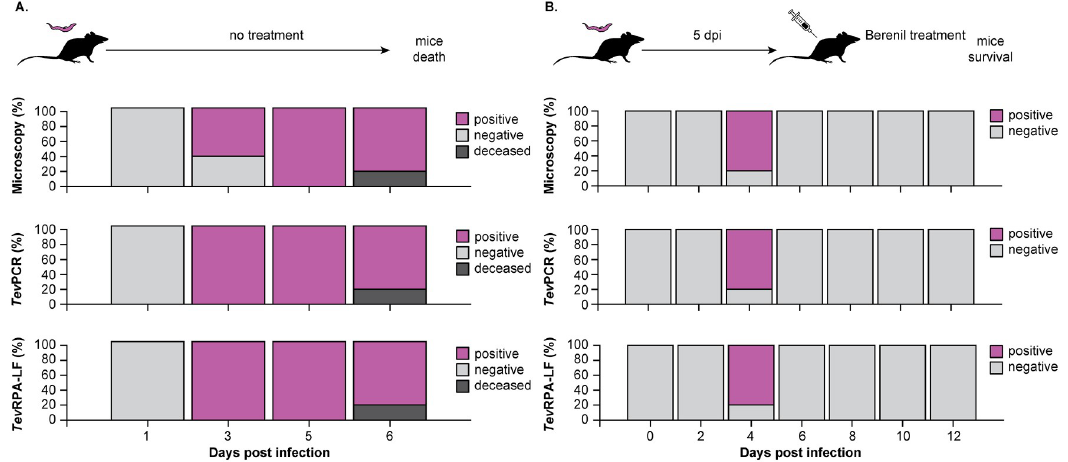
Fig 4. Evaluation of the Tev RPA-LF as a test-of-cure tool in T. evansi infections in mice. A: C57BL/6 mice were infected with T. evansi RoTat1.2 (n = 5) and the presence of parasites was monitored over the course of the infection by microscopy (top panel), the Tev PCR (middle panel, performed on parasite genomic DNA purified from the collected blood samples), and Tev RPA-LF (bottom panel, executed on crude parasite genomic DNA extracted from the collected blood). The results are displayed as the percentages of mice that scored positive or negative as determined by the above-mentioned techniques. B: C57BL/6 mice infected with T. evansi RoTat1.2 (n = 5) were treated with Berenil at 5 days post-infection. The presence of parasites was followed by microscopy, the Tev PCR and the Tev RPA-LF throughout the experiment. The panels and color codes are the same as for panel A. The Tev PCR and Tev RPA-LF read-outs are shown in Fig